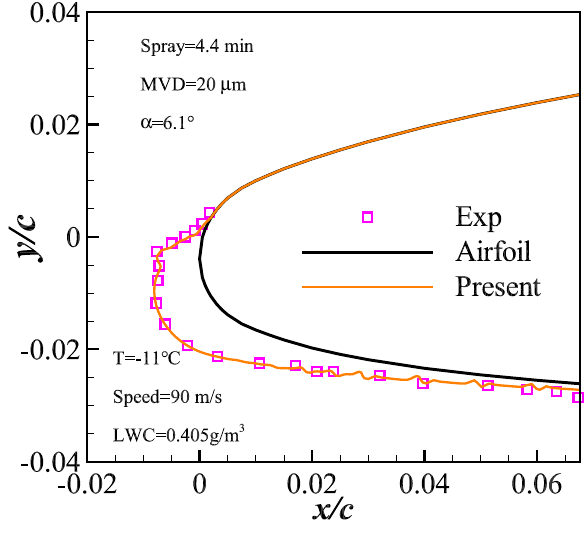
Figure 1. Rime ice condition.